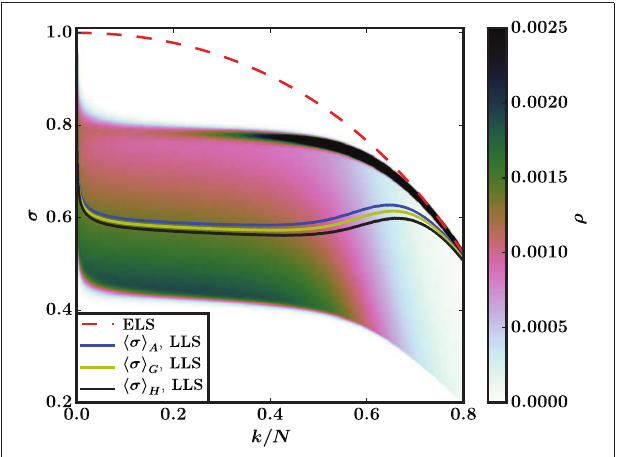
FIGURE 1 | Load curves for the ELS and LLS models with a Weibull threshold distribution P ( t ) = 1 − exp ( − t + 1 ) , Equation (4) with β = t 0 = 1. The ELS curve is Equation (3), whereas the LLS curves are sample averages—arithmetic mean h σ i A , geometric mean h σ i G , and harmonic mean h σ i H —from simulations on a square lattice ( N = 128 2 ). The background is a color map that shows the density ρ of single sample LLS load curves for the 1.5 × 10 5 samples that the averages are based on. The color bar is capped at ρ = 0.0025 to highlight the fluctuations with the smallest values of σ .